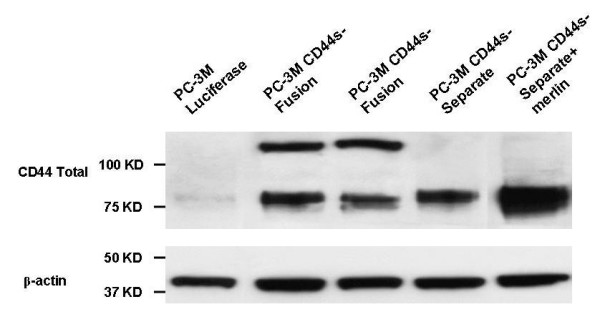
Detection of total CD44, by monoclonal antibody in PC-3M cells. The appearance of a predominant cleavage product at 75 kD (lane 1) rather than a higher molecular weight form, is expected based on our experience [1-4,14]. Re-expression of CD44s as a Fusion protein with luciferase produced a 137 kD form, with some residual 75-kD form, probably cleaved off after trypsinizing. The forced expression of CD44's intracellular binding partner merlin potentiated the increased CD44s (lane 5).